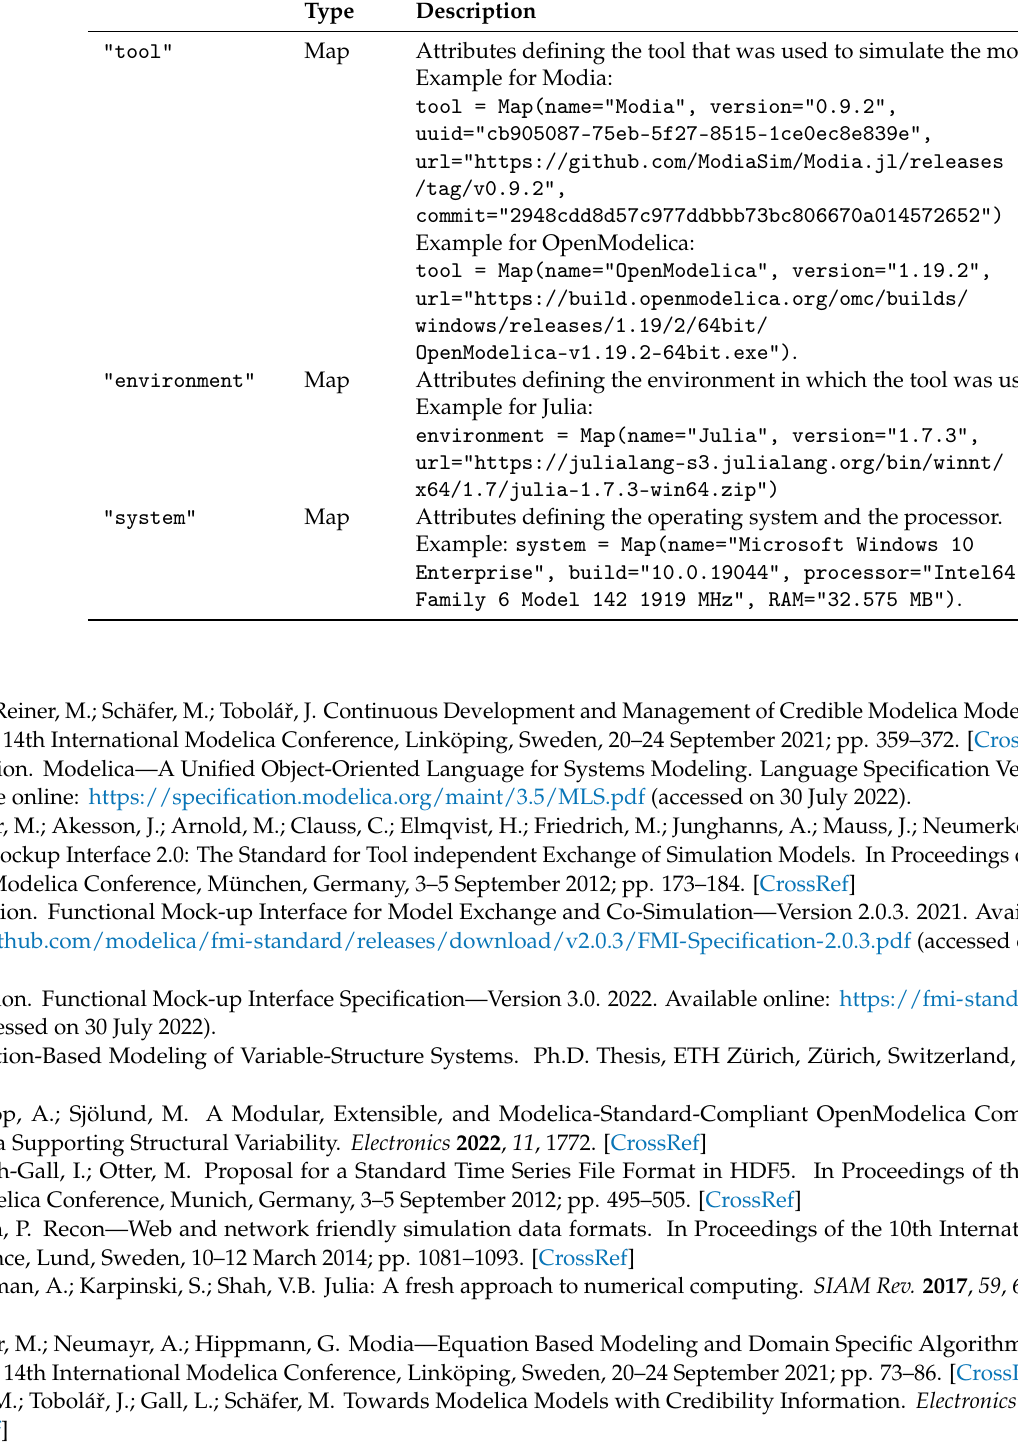
Table A3. Cont. Key Value Value Type